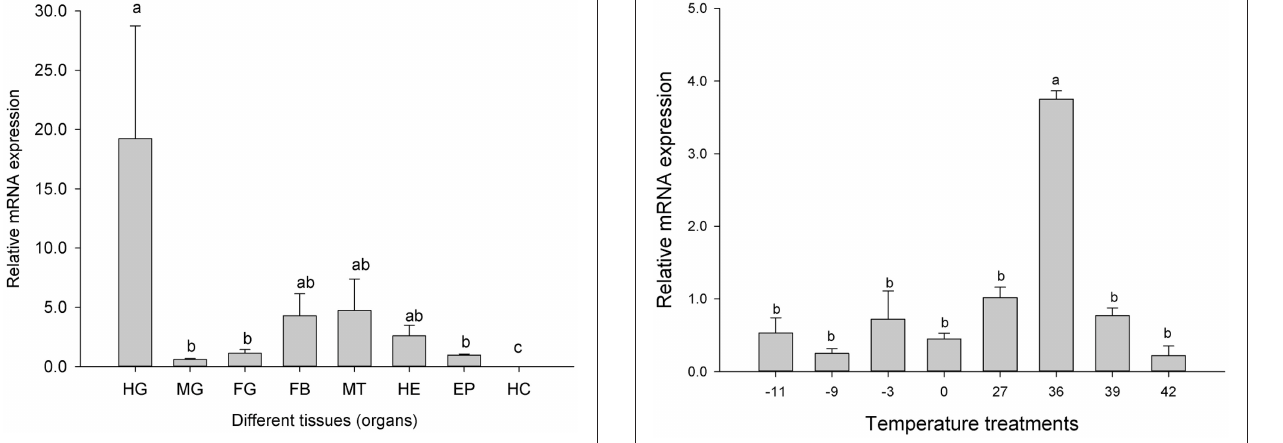
FIGURE 6 | Relative expression levels of Cs Drip1 gene in the Chilo suppressalis under temperature stress. The larvae were exposed for − 11 ◦ C, − 9 ◦ C, − 3 ◦ C, 0 ◦ C, 27 ◦ C, 36 ◦ C, 39 ◦ C, or 42 ◦ C for 2h. Values are denoted as the mean ± SE. Significant differences are indicated as P <